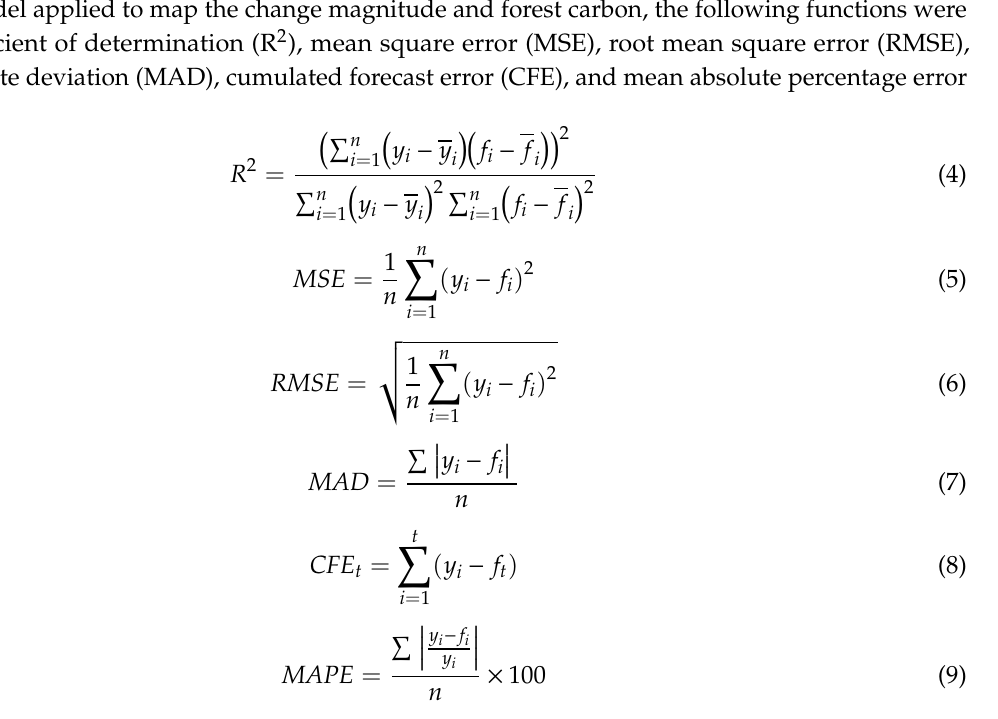
Table 1. Definitions and variables used to estimate the carbon stored in the pine forest. Variable Unit Definition / Explanation Aboveground biomass: all living and standing dead trees with a diameter at AGB Mg C ha − 1 breast height (DBH) equal to or greater than 2 cm. BGB Mg C ha − 1 Belowground live biomass: roots. Deadwood: All pieces of wood with a diameter greater than 2 cm lying on DW Mg C ha − 1 the surface of the ground or intermixed with dead leaves. Non-woody biomass is recorded, which includes dead leaves (dead biomass) Litter Mg C ha − 1 and herbaceous vegetation (living non-woody biomass on the ground). The maximum diameter for woody material to be considered is 2